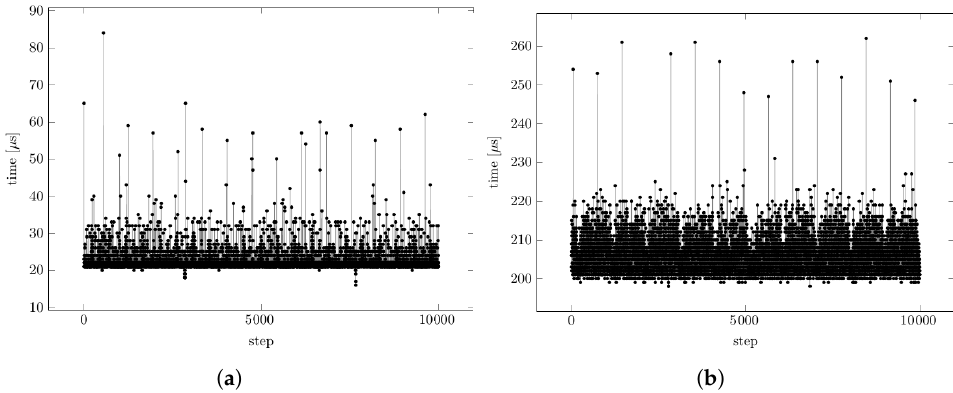
Figure 4. The evolution of the Python module execution time with interference from the garbage col- lectors, which resulted in regular spikes in the cycle times: ( a ) PID computation; ( b ) FFT computation.